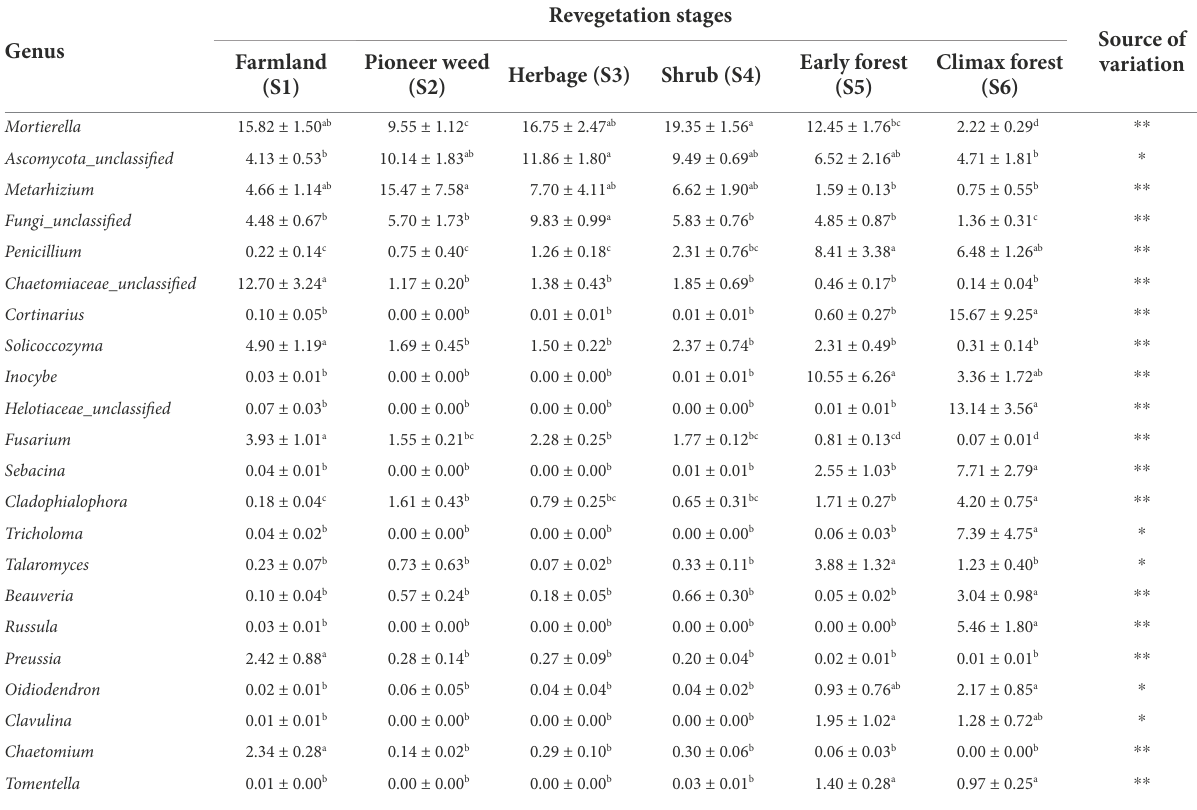
TABLE 3 Relative abundance (% of individual taxonomic groups) of the dominant fungal genera (mean ± SE, n = 4) present in the soil (0–20 cm depth) microbial communities during various revegetation stages in the Loess Plateau of China.